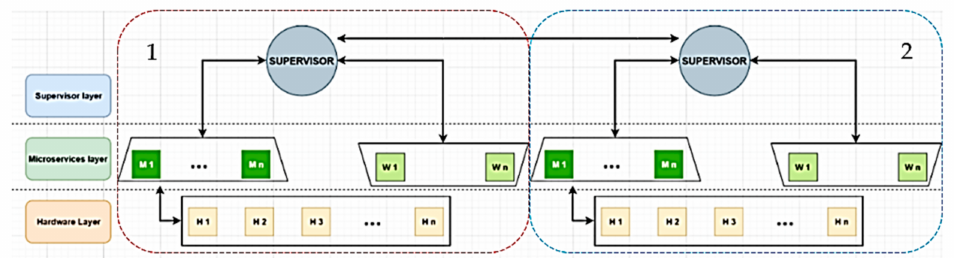
Figure 7. Normal communication process between